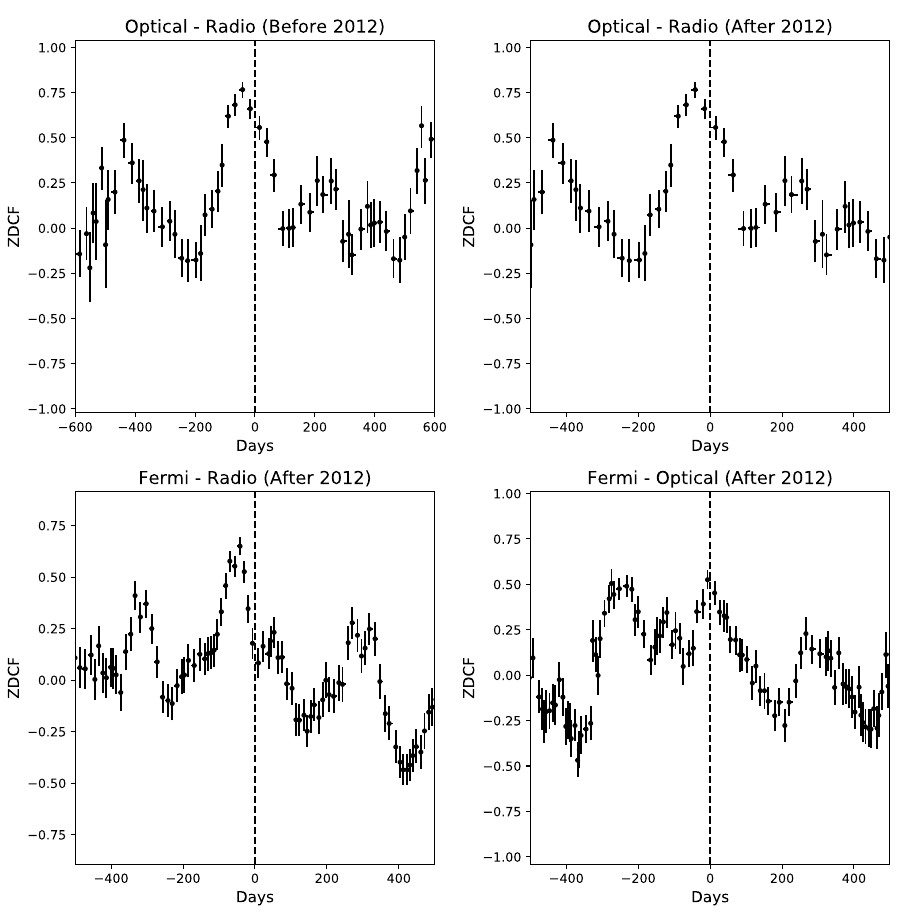
Figure 3. The significant correlation functions between all light curves. ( top left ) Optical-Radio Figure 2. The significant correlation functions between all light curves. Top left: Optical-Radio before 2012; top right: Optical-Radio after 2012; Bottom left: Fermi-Radio after 2012; bottom right: Fermi-optical before 2012; ( top right ) Optical-Radio after 2012; ( bottom left ) Fermi-Radio after 2012; ( bottom right ) after 2012. A negative lag indicates that the lower energy band comes after. Fermi-optical after 2012. A negative lag indicates that the lower energy band comes